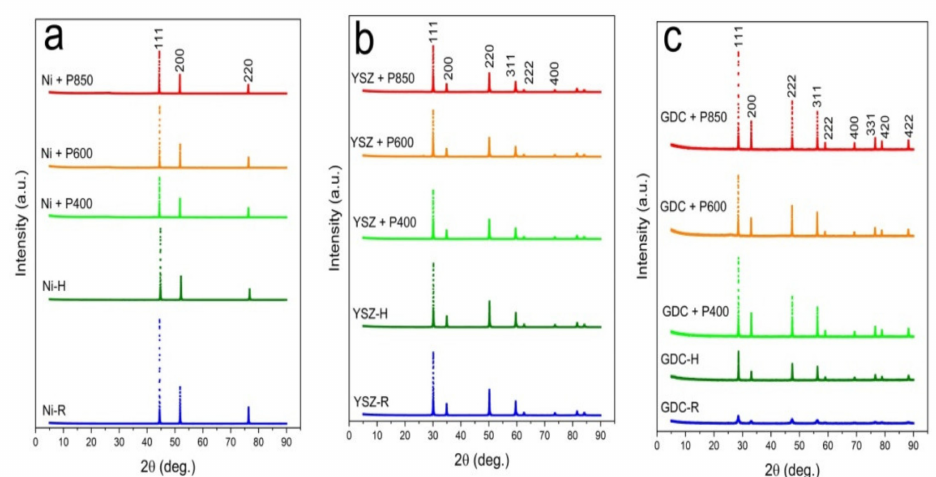
Figure 13. ( a – c ) XRD diffraction patterns for initial powder samples (marked as R) of Ni ( a ), 8YSZ ( b ), 20GDC ( c ) and same samples were additionally subjected to heating process at temperatures of 400 ◦ C, 600 ◦ C, and 850 ◦ C for 100 h, respectively, without contact with solid carbon fuels (marked H), as were a series of mixtures with carbonaceous materials that were obtained from pistachio shells.